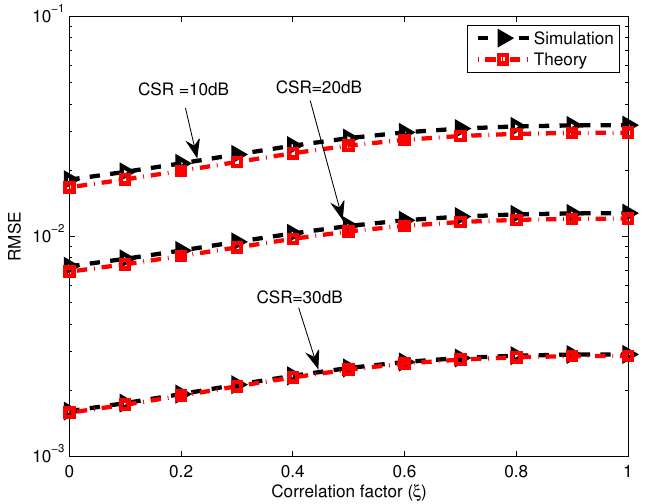
Figure 7. Gain-phase error estimation performances of the proposed method versus correlation factors of source signals, SNR = 40 dB, M = 16, K 0 = 20, T = 80, N =